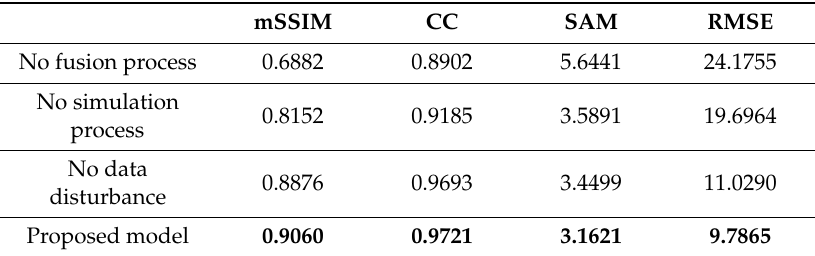
Table 3. Ablation Study in Terms of the Three Main Operations.